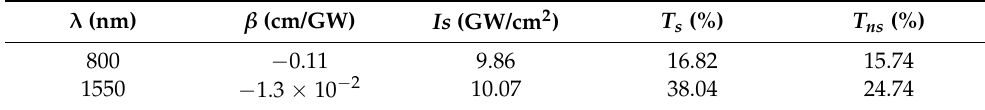
Figure 5. OA Z-scan measurements of 2D BP/InSe heterostructure at ( a ) 800 and ( c ) 1500 nm. Relationship between normalized transmittance of 2D BP/InSe heterostructure and input peak intensity of the femtosecond laser at ( b ) 800 and ( d ) 1500 nm. Table 1. NLO parameters of BP/InSe at different wavelengths.